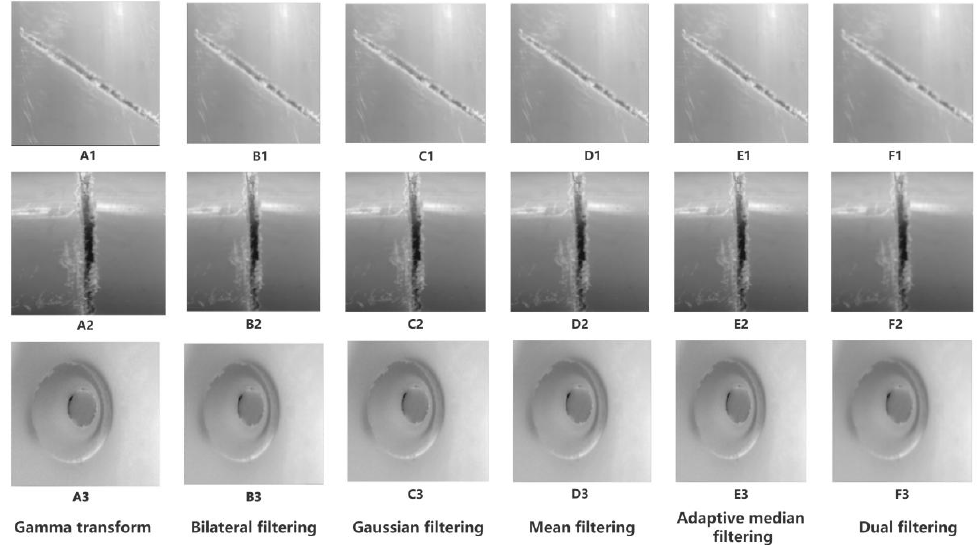
Figure 5. Comparison of pipeline defect image filtering methods.